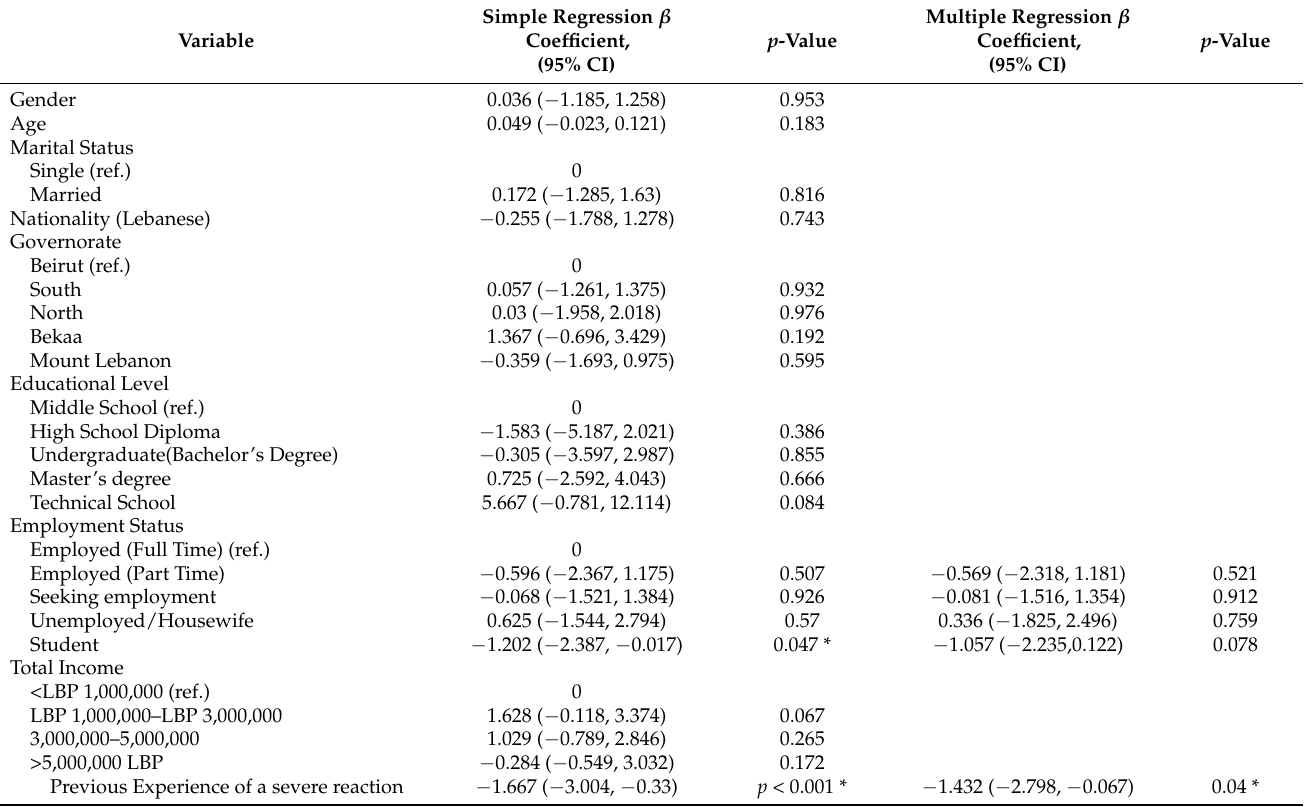
Table 8. Linear regression analysis of food allergen attitude scores with sociodemographic